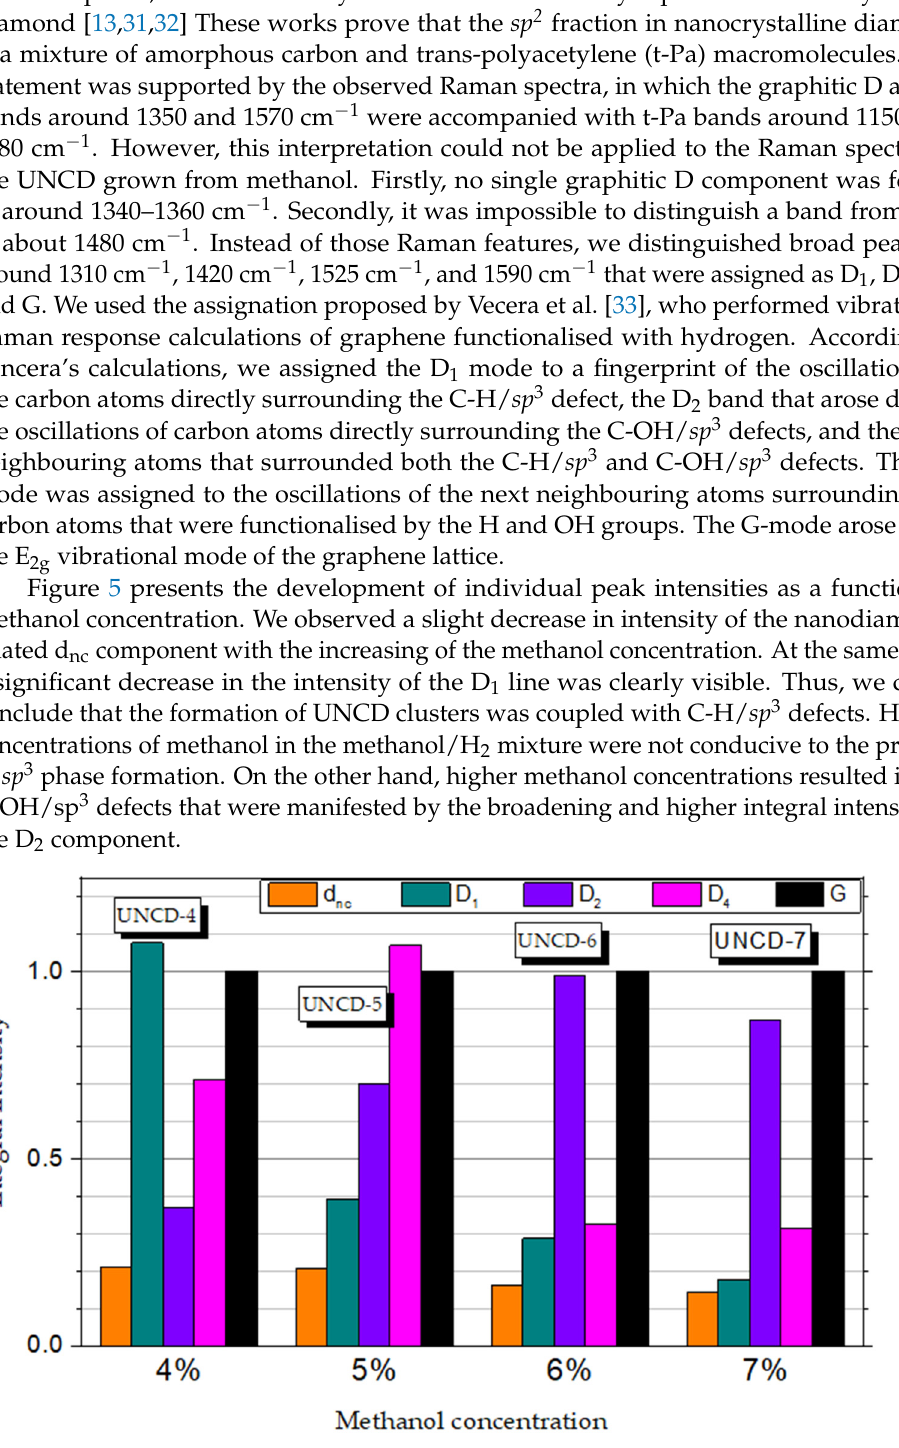
Figure 5. Comparison of integral intensities of Raman features’ components normalised to the intensity of the G band.